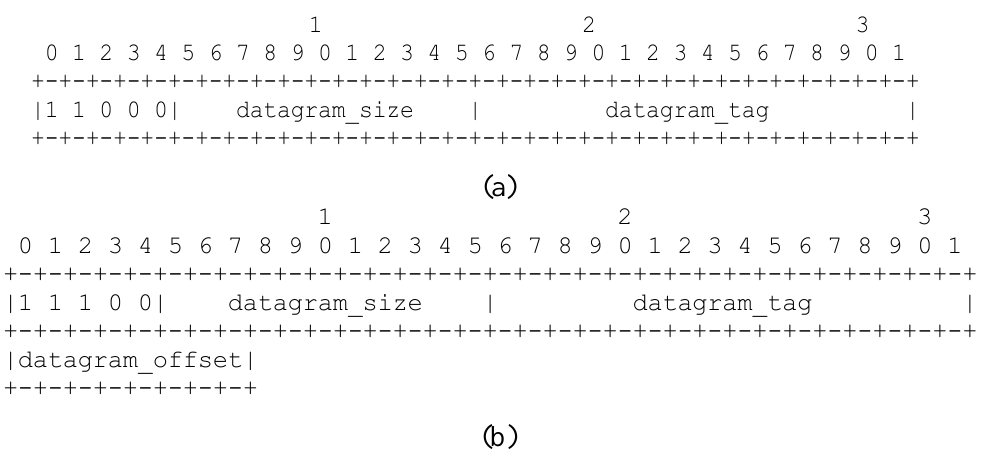
Figure 1. 6LoWPAN Fragment headers. (a) First fragment; (b) Subsequent